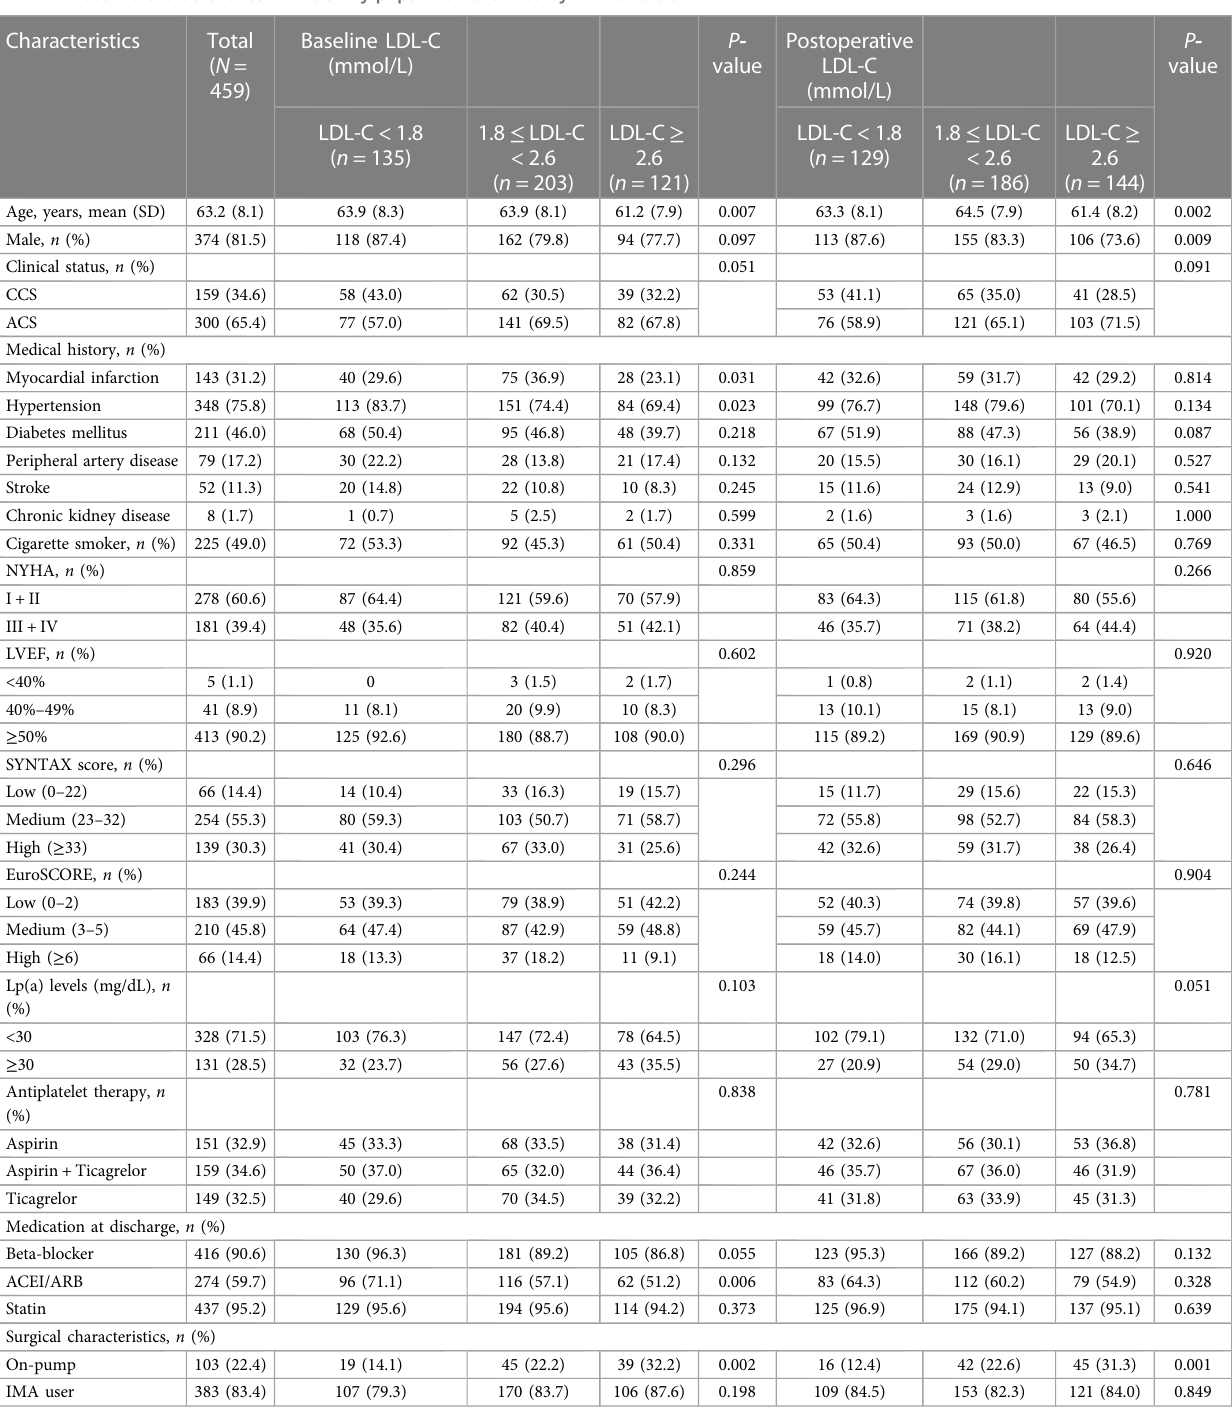
TABLE 1 Baseline characteristics of the study population strati fi ed by LDL-C levels.